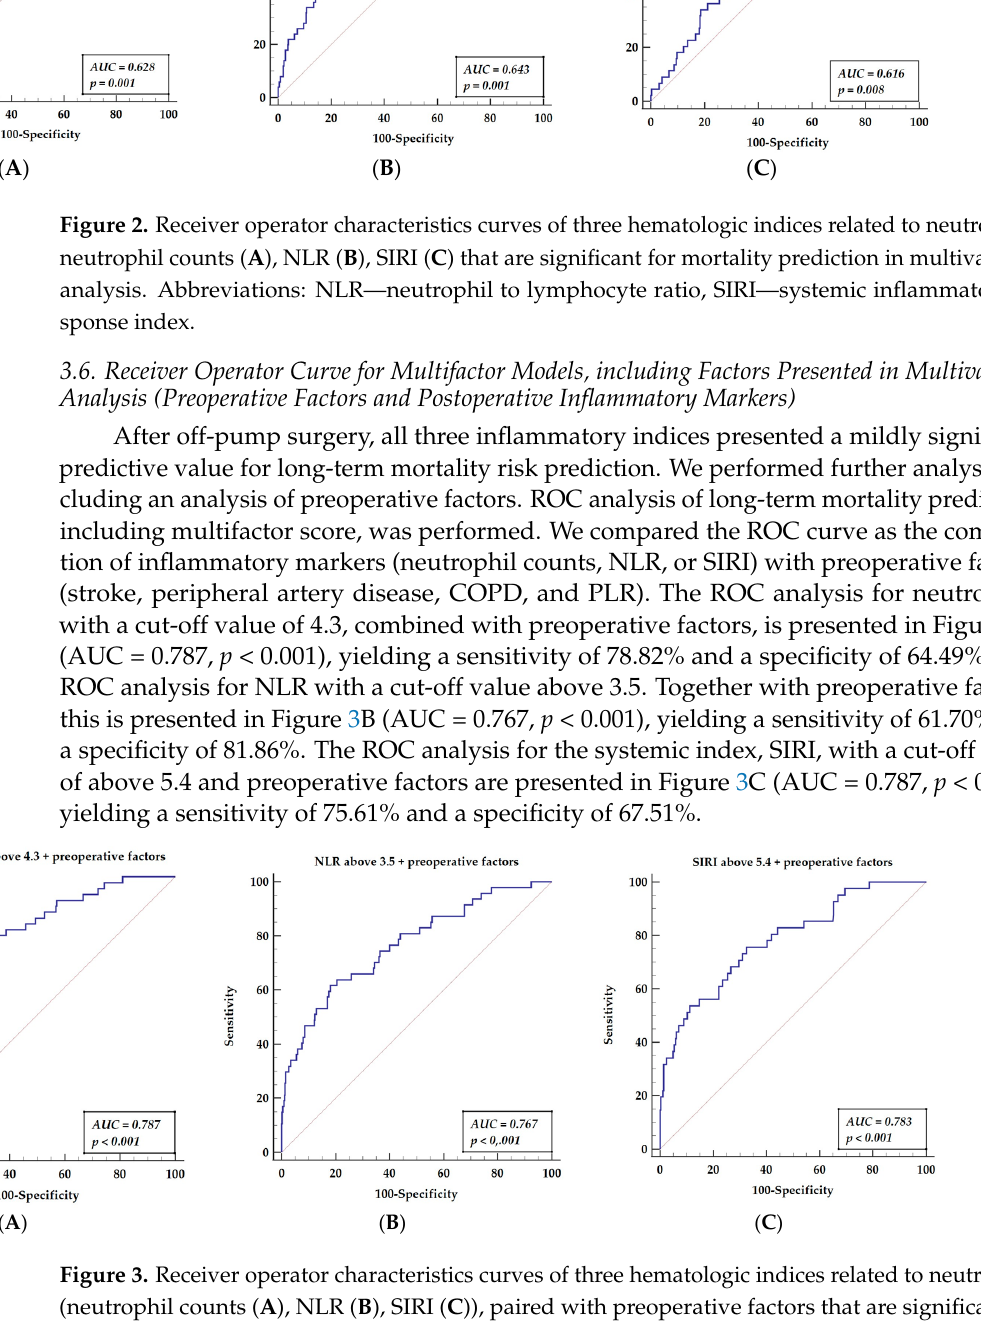
Table 5. Results of different compositions of multifactorial models affecting long-term survival. Variable